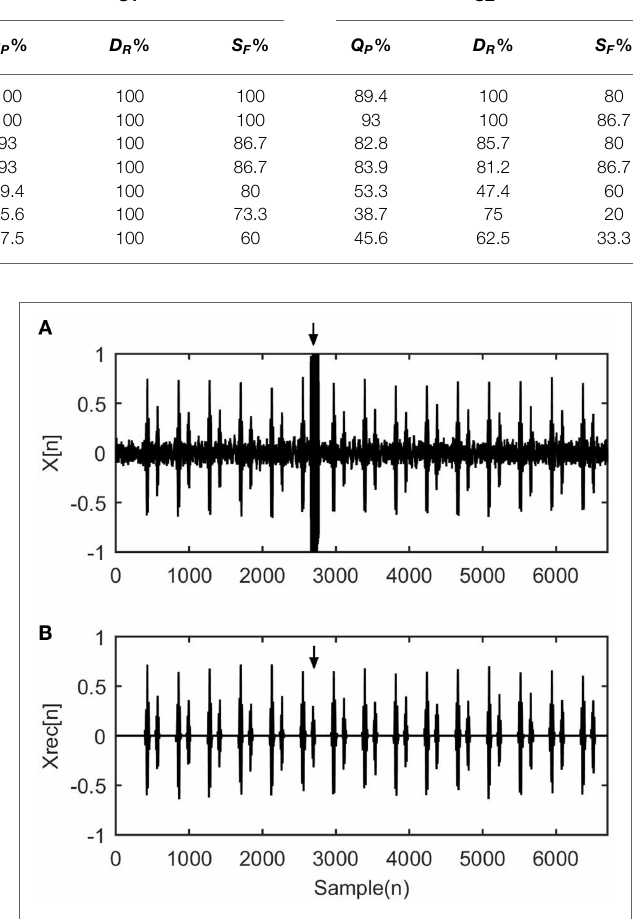
FIGURE 3 | Experimental result from the application of the wavelet transform–fractal dimension scheme to simulated fetal phonocardiograph signal. (A) X [ n ] represents a section of 5,000 samples of a normal heart rate case with unexpected robust noise. (B) X REC [ n ] corresponds to the normalized treated signal without the overlap of noise. The arrows indicate the location of the S2 sound that the algorithm efficiently reveals.